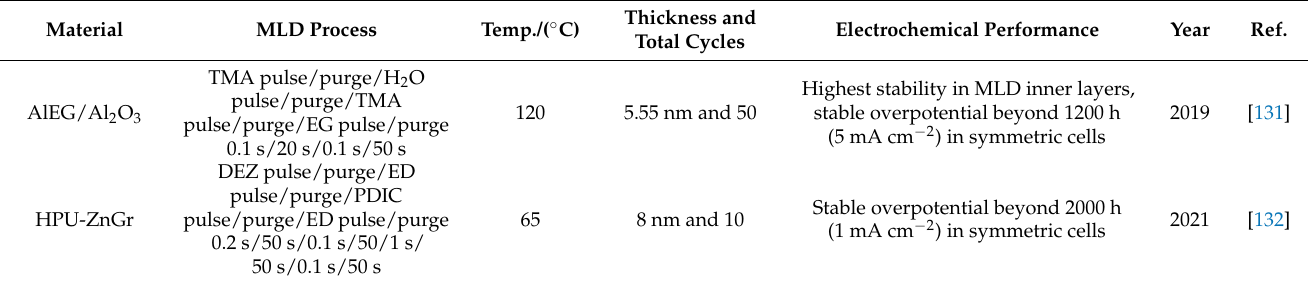
Table 5. Summary of ALD/MLD Dual Layer Surface